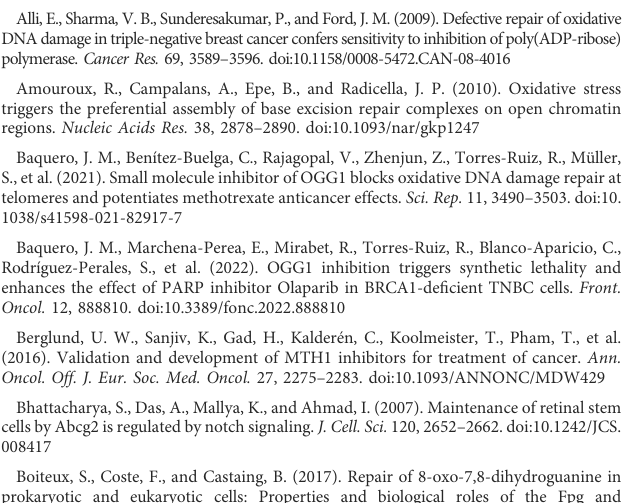
SUPPLEMENTARY FIGURE S3 SU0268 induces mitosis block in different cell lines. Cells undergoing mitosis were quanti fi ed by fl ow cytometry using an antibody against Phospho-H3. A higher accumulation of cells in mitosis was observed for HMLE, T47D, and A549 cells exposed to SU0268 compared to untreated cells or cells exposed to TH5487. The percentage of cells positive for phosphor-H3 is indicated in the